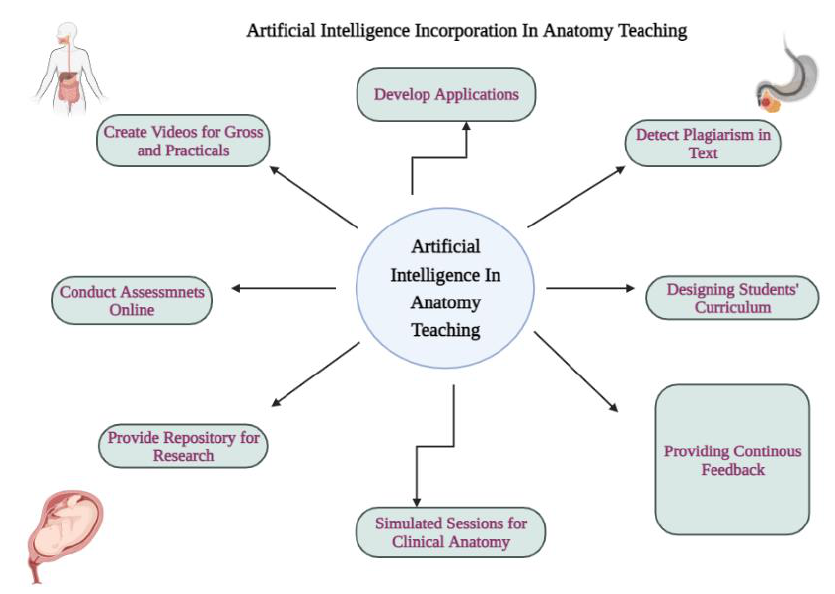
Figure 4. Schematic diagram showing how artificial intelligence can be incorporated in anatomy Figure teaching.